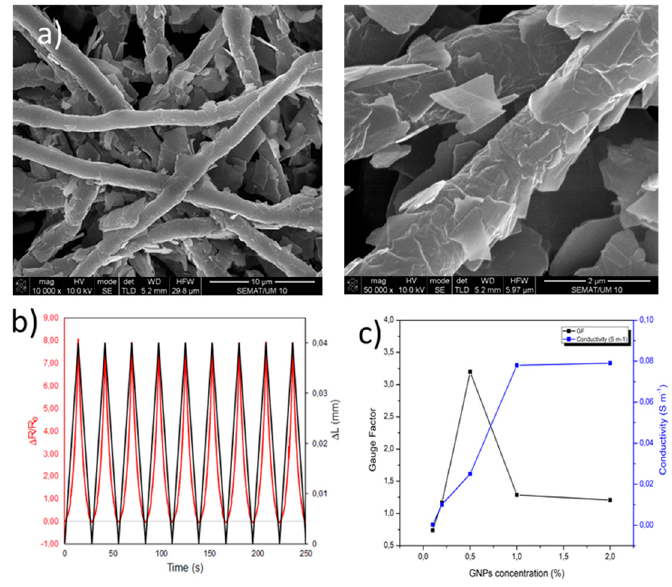
Figure 9. FESEM images of PCL microfibers with GNPs ( a ). Piezoresistive response of GNPs-PCL membrane ( b ). Electrical conductivity and GF in relation to the GNPs concentration of GNPs-PCL membrane ( c ) [115].